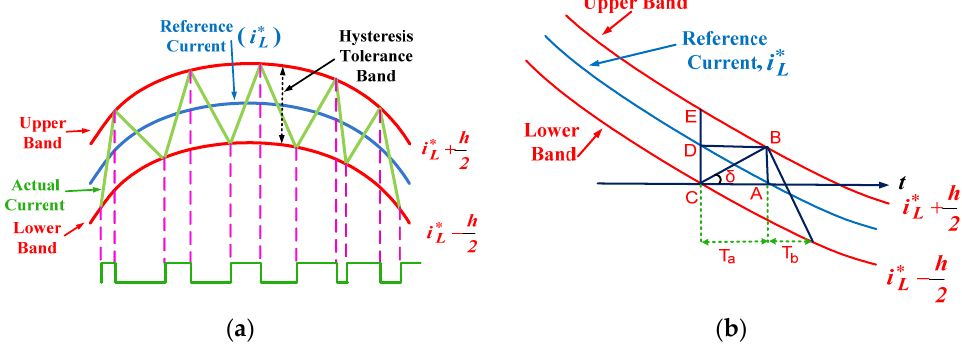
Figure 6. Hysteresis current control under: ( a ) normal condition; and ( b ) worst case